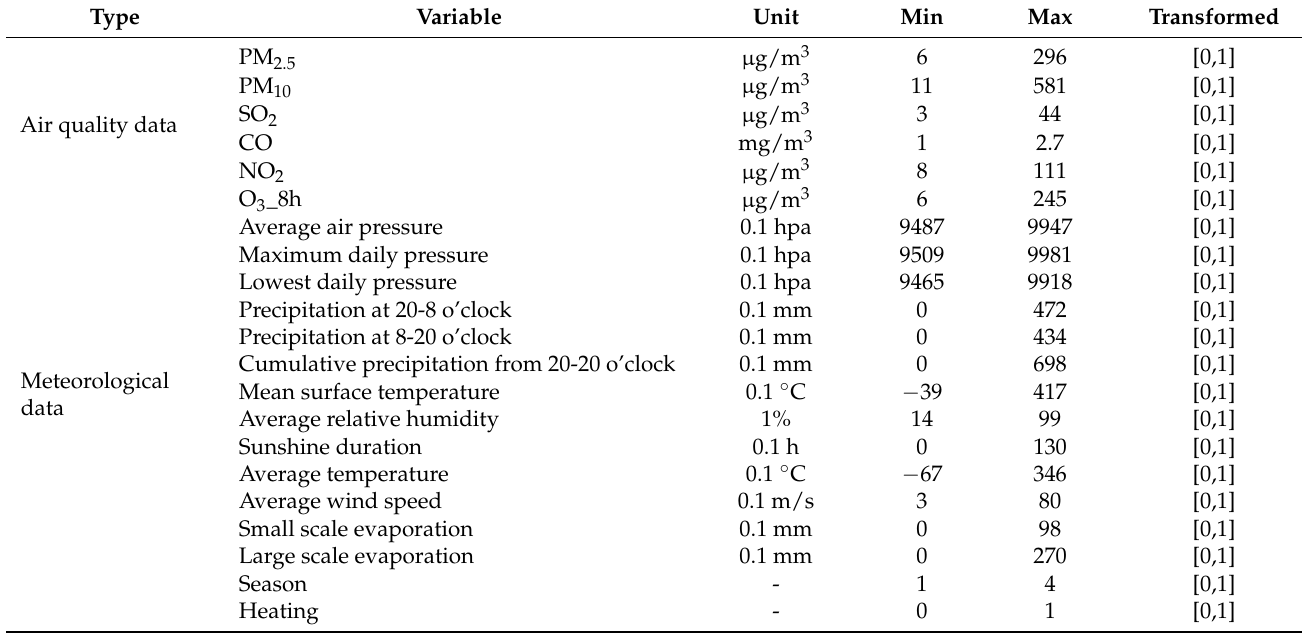
Table 1. Quantification of candidate input variables for air pollutant concentration prediction